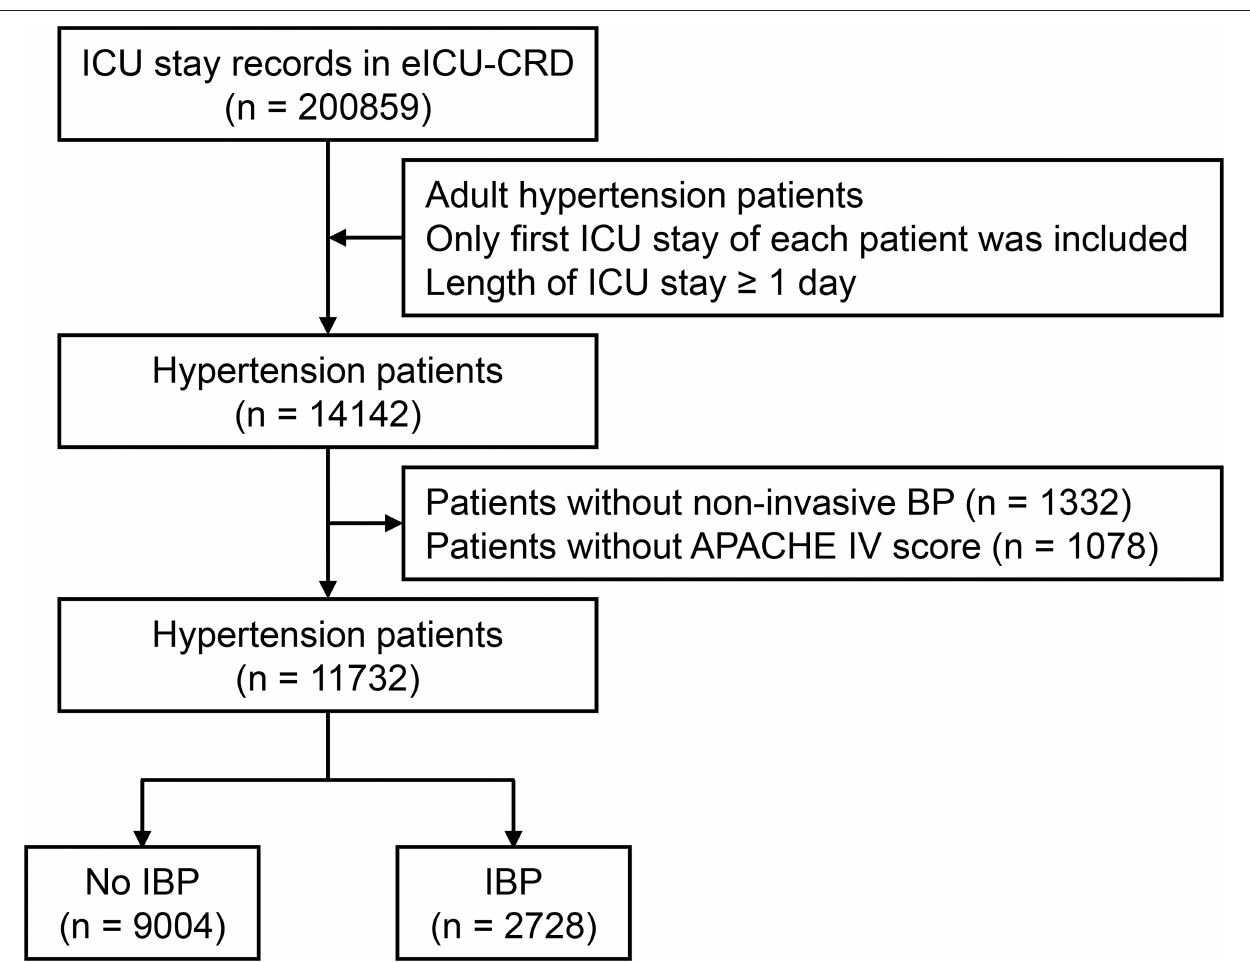
FIGURE 1 | Flow chart of subject enrollment. A total of 11,732 hypertensive patients from eICU-CRD were enrolled in this study. ICU, intensive care unit; eICU-CRD, eICU Collaborative Research Database; BP, blood pressure; APACHE, Acute Physiology and Chronic Health Evaluation; IBP, invasive blood pressure.